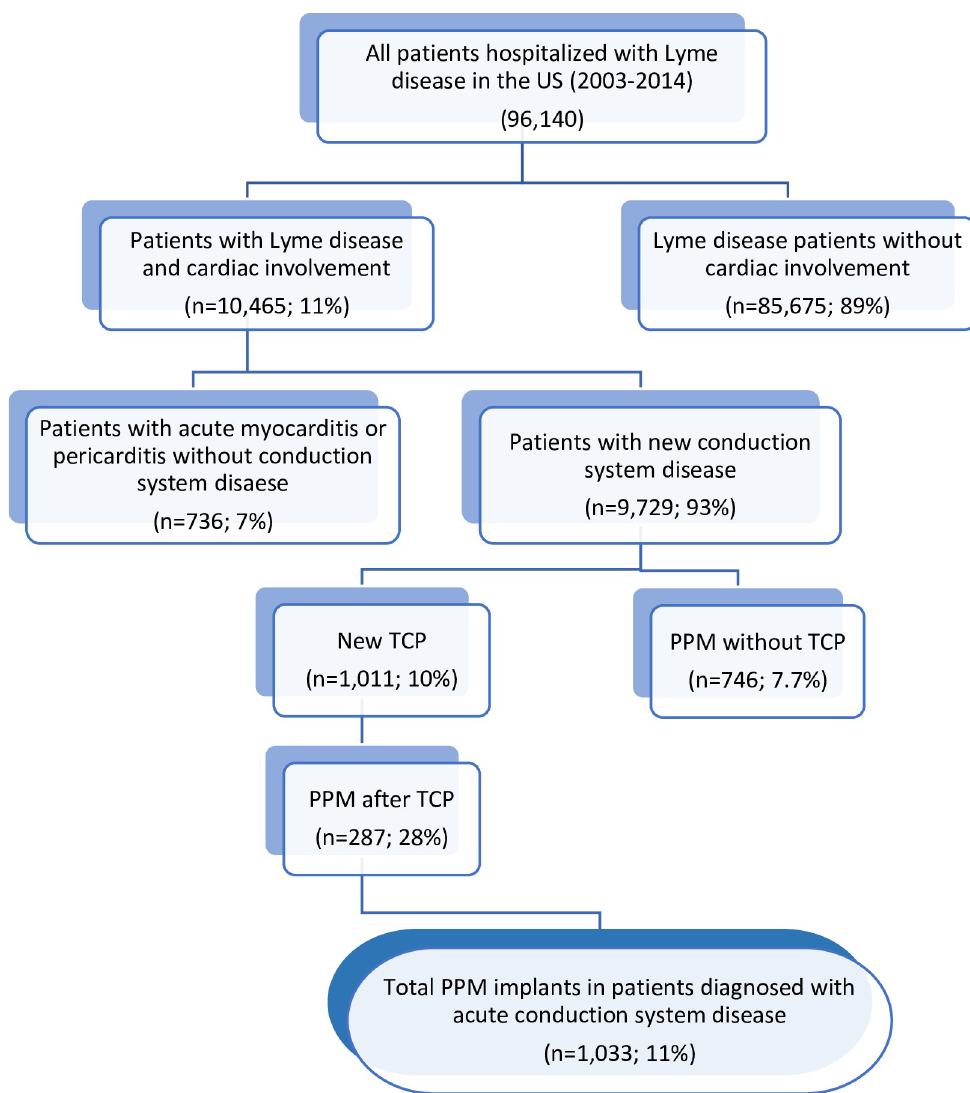
Fig 1. Proportion of patients hospitalized with Lyme disease who underwent implant of permanent pacemakers. Flow chart showing the total number of patients hospitalized with Lyme disease in the US during the study period. Also displayed is the number of patients with cardiac issues related to Lyme disease, including: myocarditis, pericarditis, and conduction system disease (CCD). Some patients with Lyme-related CCD underwent implant of a permanent pacemaker (PPM) after implant of a temporary cardiac pacemaker (TCP). Other patients with Lyme-related CCD underwent PPM implant without first undergoing TCP implant.